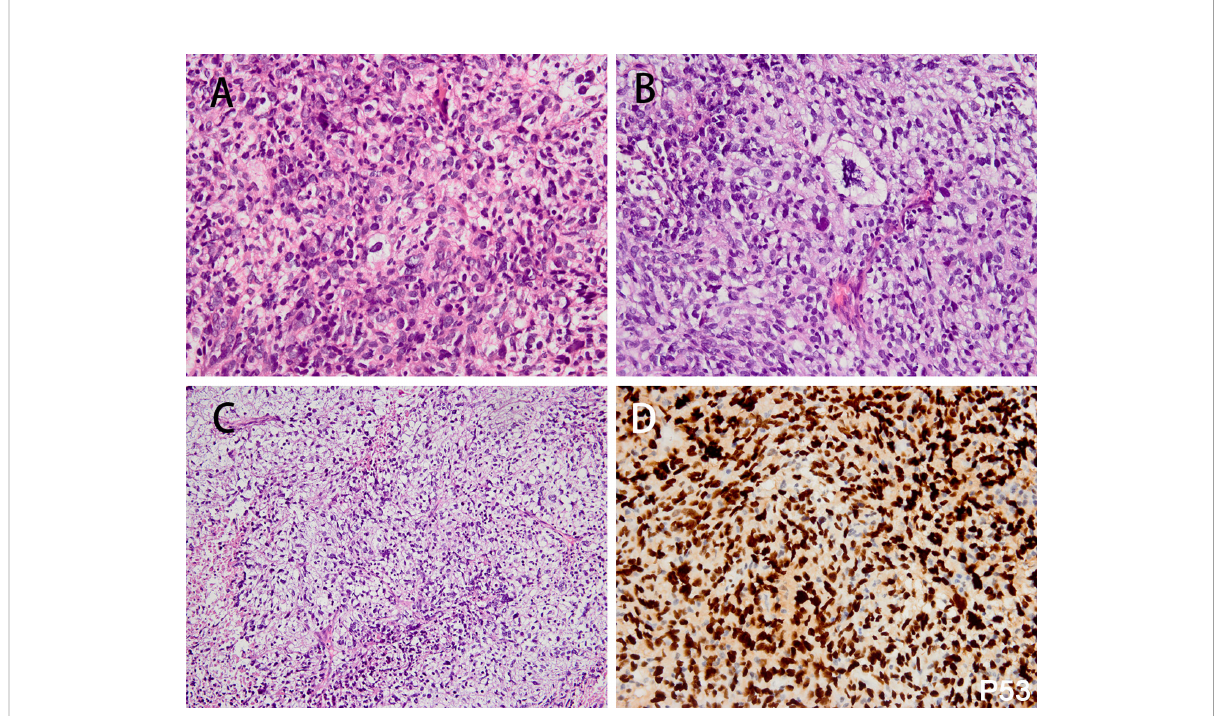
FIGURE 6 The histologic features of pleomorphic liposarcoma and corresponding immunohistochemical results. The spindled, epithelial tumor cells exhibited marked nuclear atypia ( A H&E; magni fi cation: 400×) (case 43). The bizarre lipoblasts can be identi fi ed within the lesion ( B H&E; magni fi cation: 400×). Myxoid change in focal area, resembling the morphology of myxo fi brosarcoma ( C H&E; magni fi cation: 200×). The tumor cells were diffusely positive for P53 ( D magni fi cation: